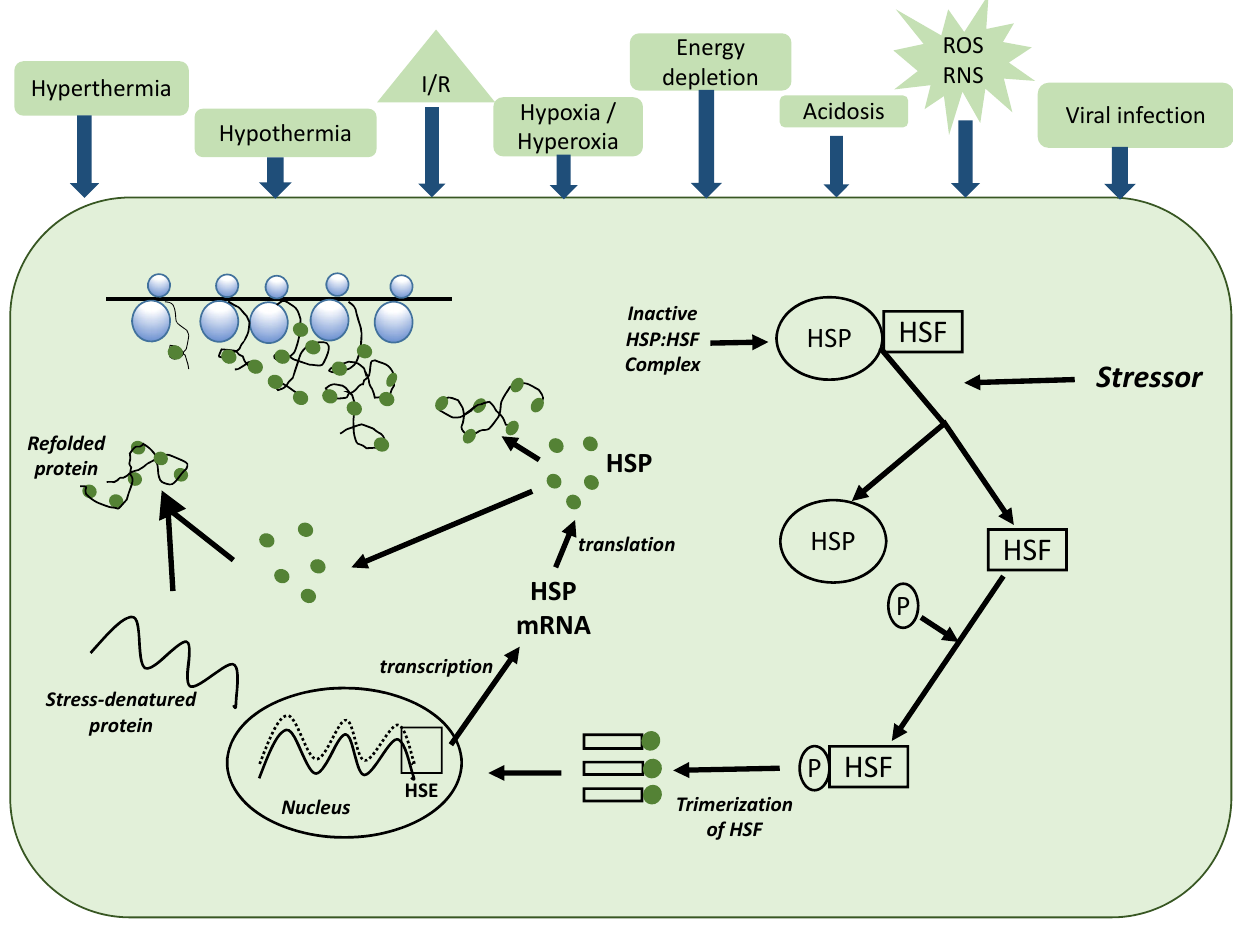
Figure 1. Molecular mechanism for the expression of HSP70 within a cell, adapted from Kregel [40]. The HSP70 expression is modulated by some physiological signals like thermal stress, energy depletion, acidosis, and viral infection. These physiological stimuli activate the heat shock factors (HSFs), causing them to seperate from heat shock proteins (HSPs). The HSFs are phosphorylated by protein kinases and form trimers in the cyto- sol. These HSF trimer complexes enter the nucleus and bind to heat shock elements (HSE) in the promotor region of the HSP70 gene. HSP70 mRNA is then transcribed and leaves the nucleus for the cytosol, where new HSP70 is synthesized. Proposed mechanisms of cellular protection for HSPs include their functioning as molecular chaperones to assist in the assembly and translocation of newly synthesized proteins within the cell and the repair and refolding of damaged (e.g., stress-denatured)